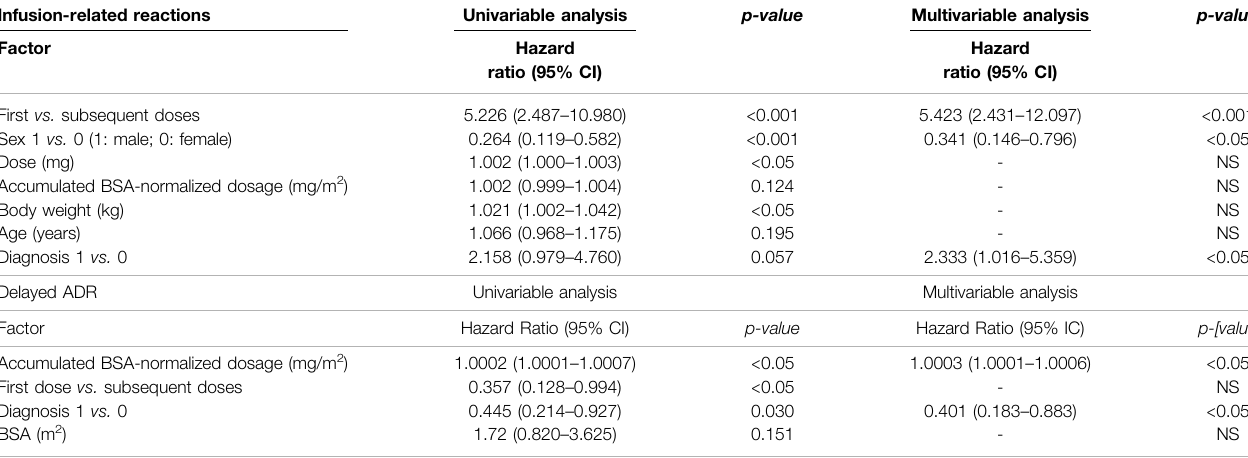
TABLE 6 | Univariable and multivariable analysis for the development of IRR and delayed ADR to rituximab in the study